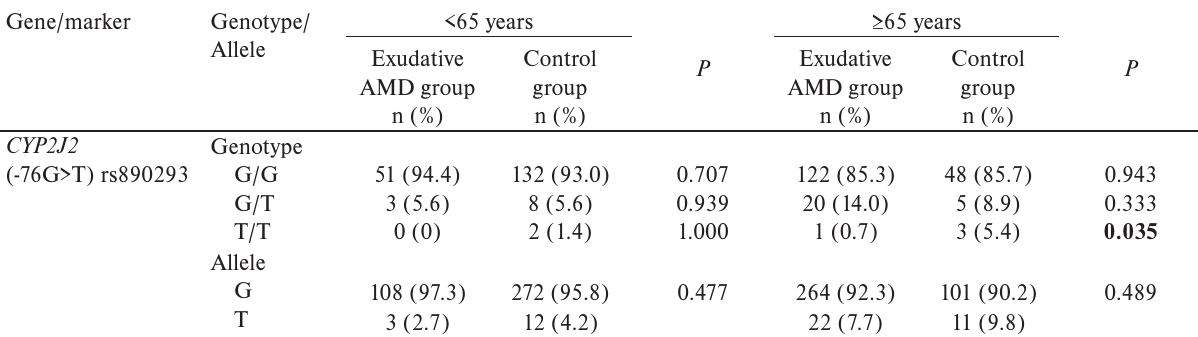
Table 4. Frequency of CYP2J2 (-76G>T) rs890293 genotypes in patients with exudative age-related macular degeneration (AMD) and control individuals by age.